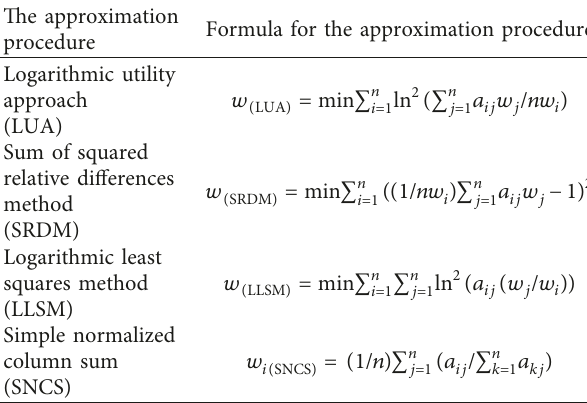
Table 3: Formulae for the approximation